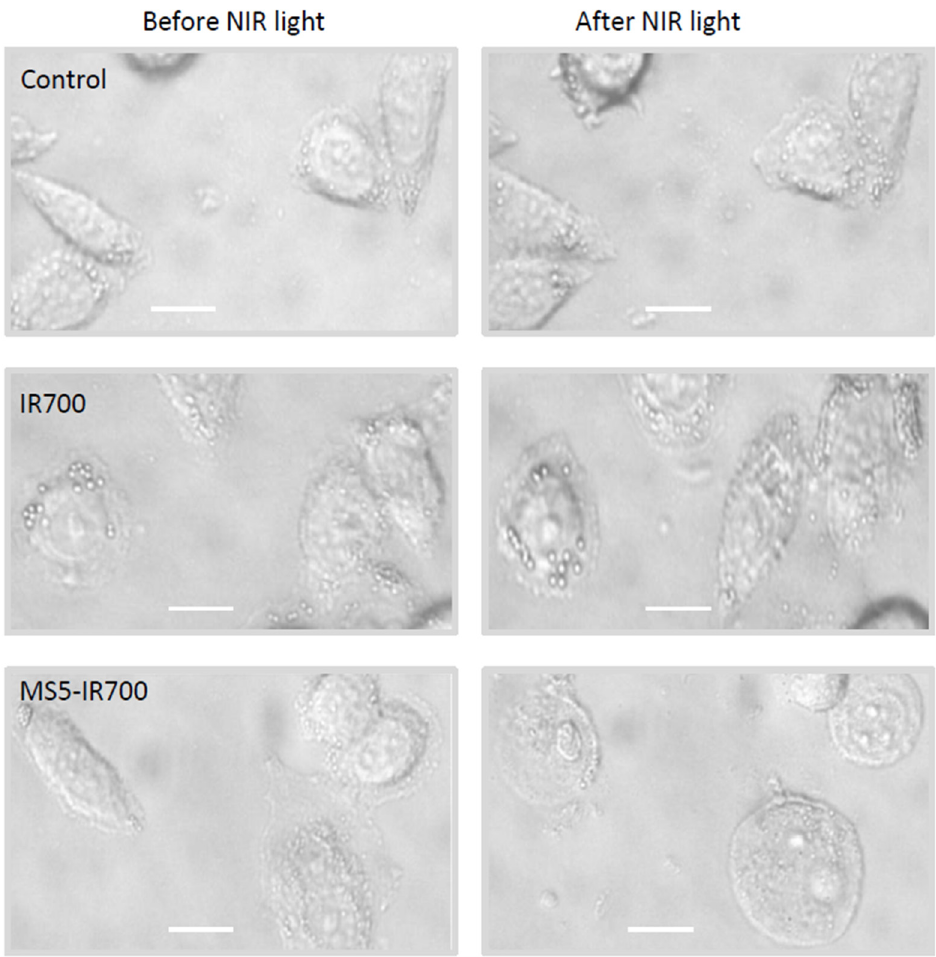
Figure 3. Cell morphology before and post-NIR light irradiation. Images presenting the morphology of PC3 cells incubated with IR700 (50 nM) or MS5-IR700 conjugate (5 µ g/mL) before and after exposure to NIR light 35 J/cm 2 at a power density of 17 mW/cm 2 . After irradiation, the cells were placed at 37 ◦ C for 30 min and then the images were recorded. Of note, the cells have moved slightly from their initial locations after light irradiation. The images present morphologies that are representative of 5 independent wells. Magnification 40 × . Scale bars present 20 µ m.